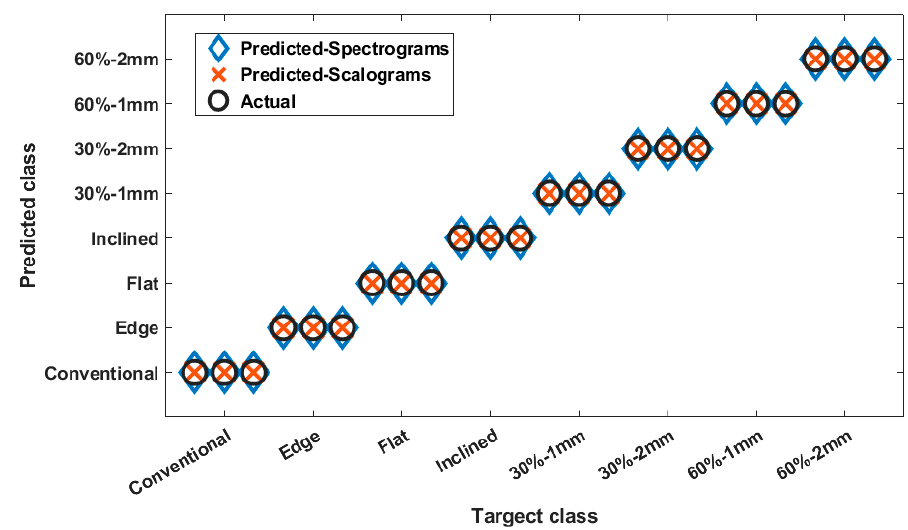
Figure 9. Classification results for all parts under no loading.